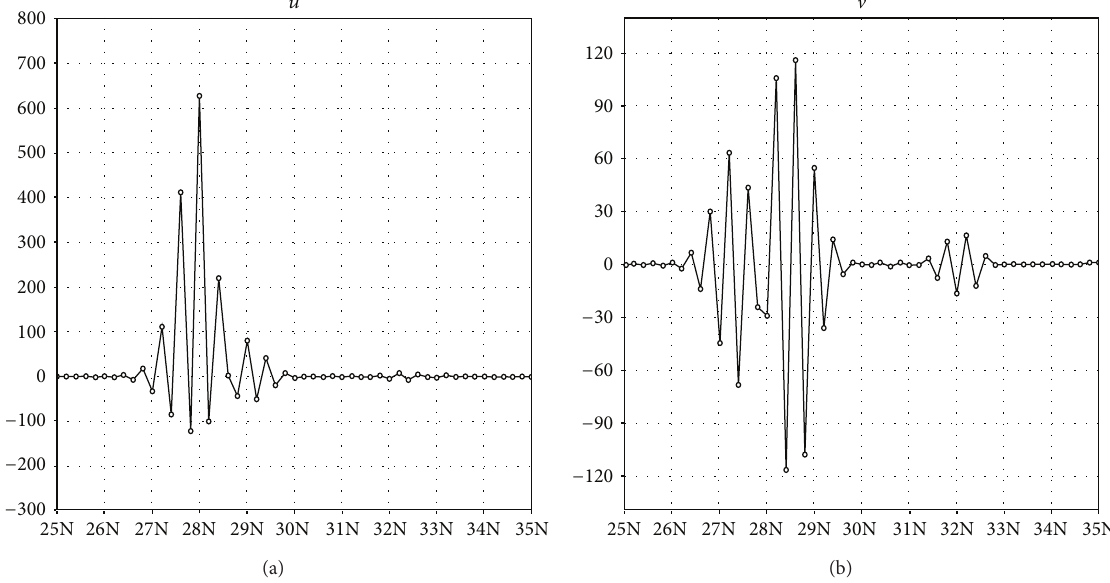
Figure 3: The figures show the values of the zonal velocity 𝑢 and the meridional velocity V at the longitude 135 ∘ E after running the model with 30 steps.